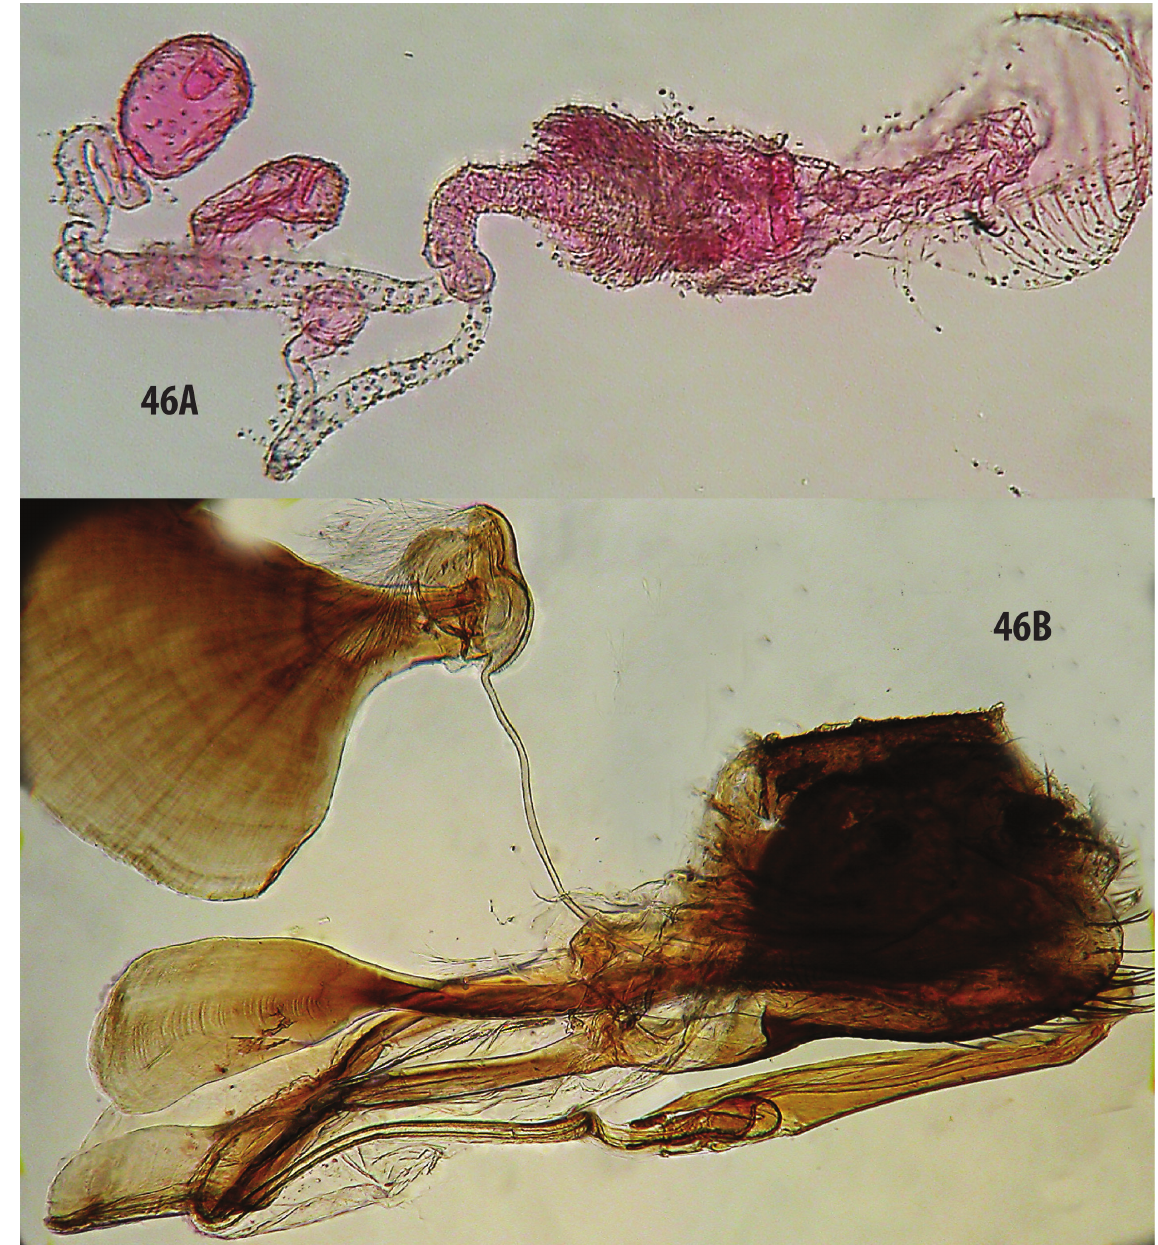
Fig. 46. Mesoconius oblitus (Hennig, 1935), internal characters. A . Spermathecae and associated structures, specimen from Colombia. B . Male terminalia, left lateral view, specimen from